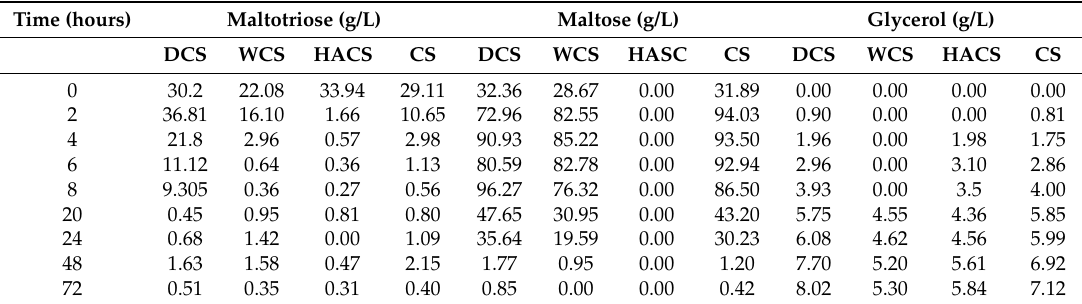
Table 3. Concentrations of other sugars in conventional process.